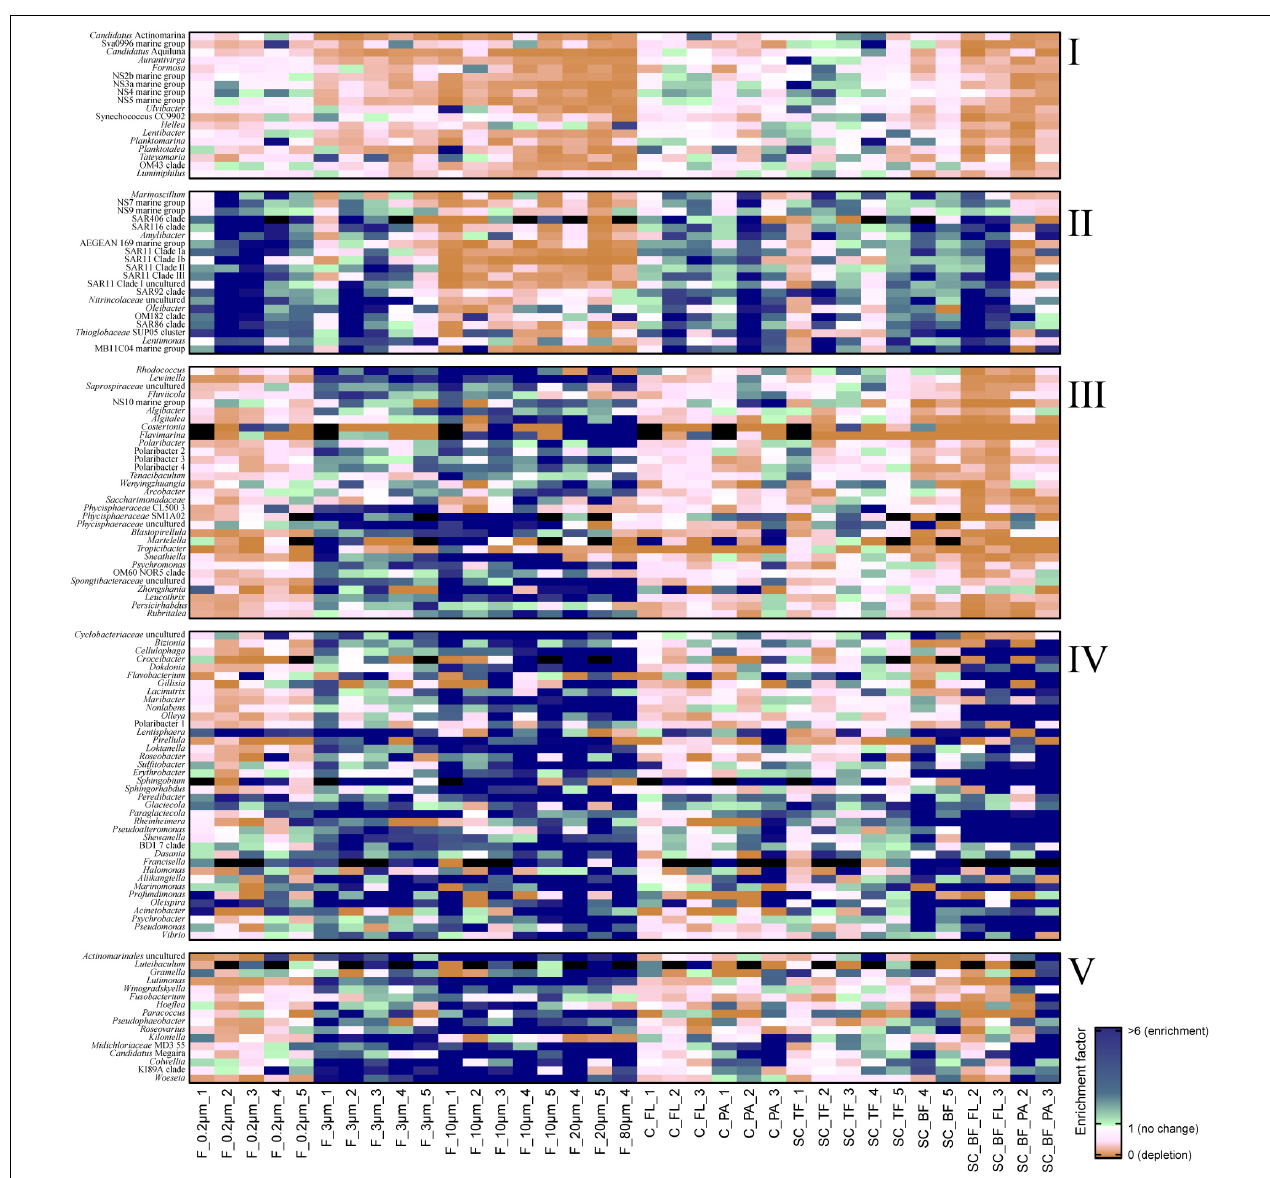
FIGURE 3 | Heatmap of enrichment factors: experimental separation of cells resulted in five operational taxonomic unit (OTU) patterns that were characterized by (I) an overall depletion of free-living genera, (II) enriched free-living genera, (III) particle-attached genera that were not enriched in the bottom fraction, (IV) particle-attached genera present in the bottom fraction as free-living and as particle-attached cells, and (V) particle-attached genera enriched in the bottom fraction. C_FL , supernatant fraction of a separation by centrifugation (with free-living cells); C_PA , particle fraction of a separation by centrifugation; F_0.2 µ m , filtered fraction ranging from 3 to 0.2 µ m; F_3 µ m , filtered fraction ranging from 10 to 3 µ m; F_10 µ m , retentate fraction > 10 µ m; F_20 µ m , plankton net catch > 20 µ m; F_80 µ m , plankton net fraction > 80 µ m; SC_TF , sedimentation cone top fraction; SC_BF , sedimentation cone bottom fraction; SC_BF_FL , free-living cells in sedimentation cone bottom fraction; SC_BF_PA , particle-attached cells in sedimentation cone bottom fraction. Numbers at the end of the sample names indicate sampling time points (Julian Days 102, 109, 115, 128, and 142). Dark blue , enrichment factor ≥ 6; light green , enrichment factor 2–6; white , enrichment factor 1 (=no enrichment or depletion); brown , enrichment factor < 1 (=depletion); black , OTU relative read abundance was in seawater below the detection limit, and thus, no enrichment factor could be